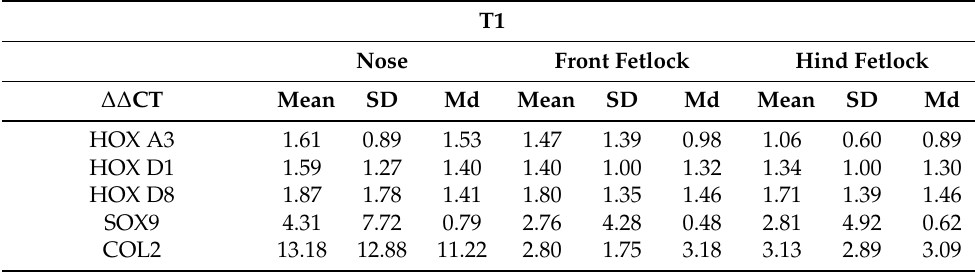
Table 2. Descriptive statistics for